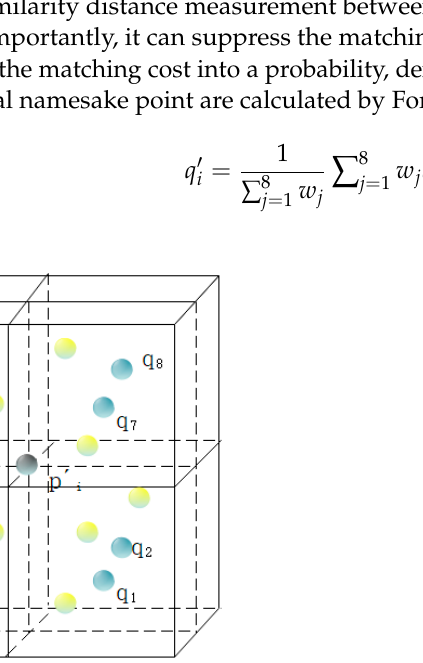
Figure 5. Construct voxel diagram.